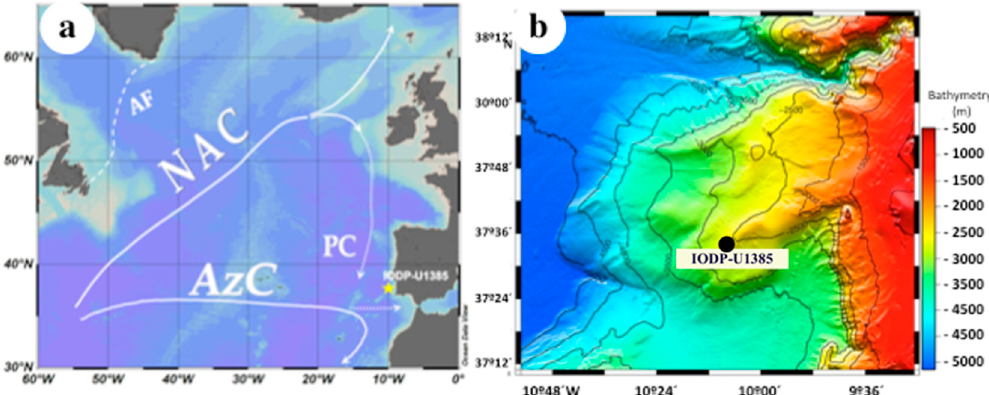
Figure 1. ( a ) Surface circulation in the North Atlantic and location of the study-site. AF , Arctic Front; AzC , Azores Current; NAC , North Atlantic current ; PC , Portugal Current. ( b ) Site U1385 bathymetry [40].